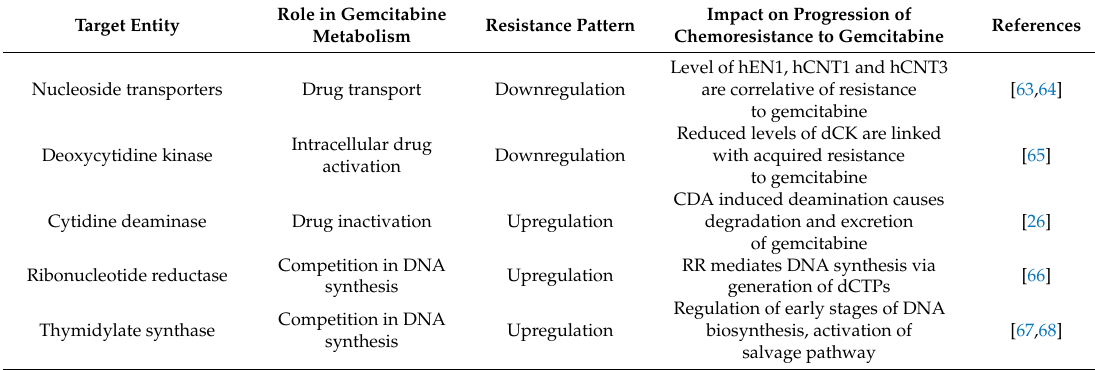
Table 1. Gemcitabine metabolism-associated chemoresistance entities in pancreatic